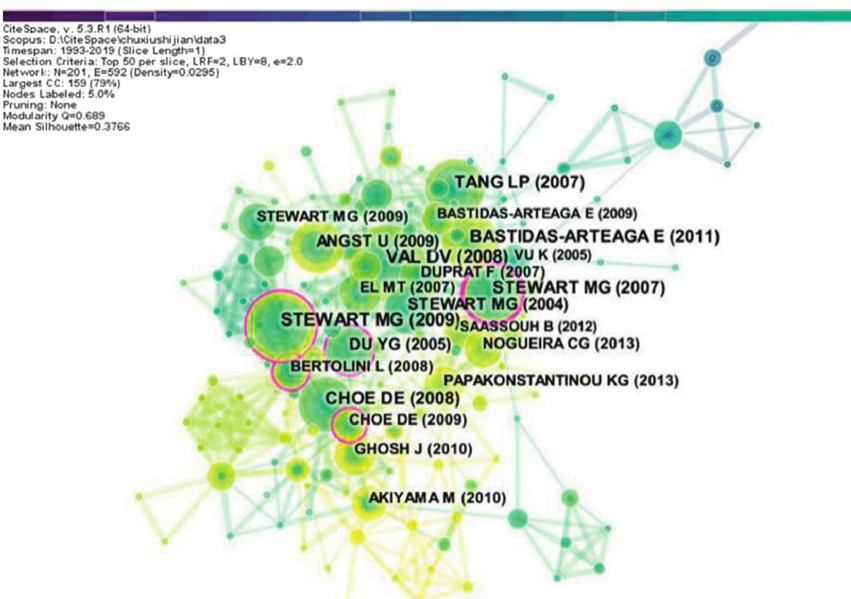
Figure 7: Document cocitation network on reinforcement initial corrosion time evaluation